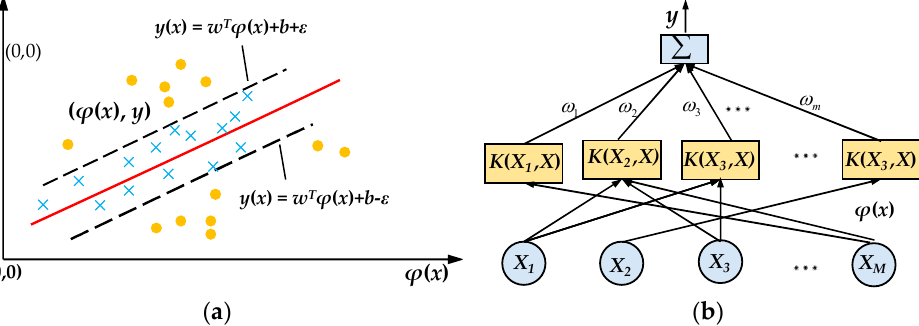
Figure 6. Schematic map of SVR: ( a ) a diagram of mapping optimal separating hyper plane; ( b ) structure of kernel function.